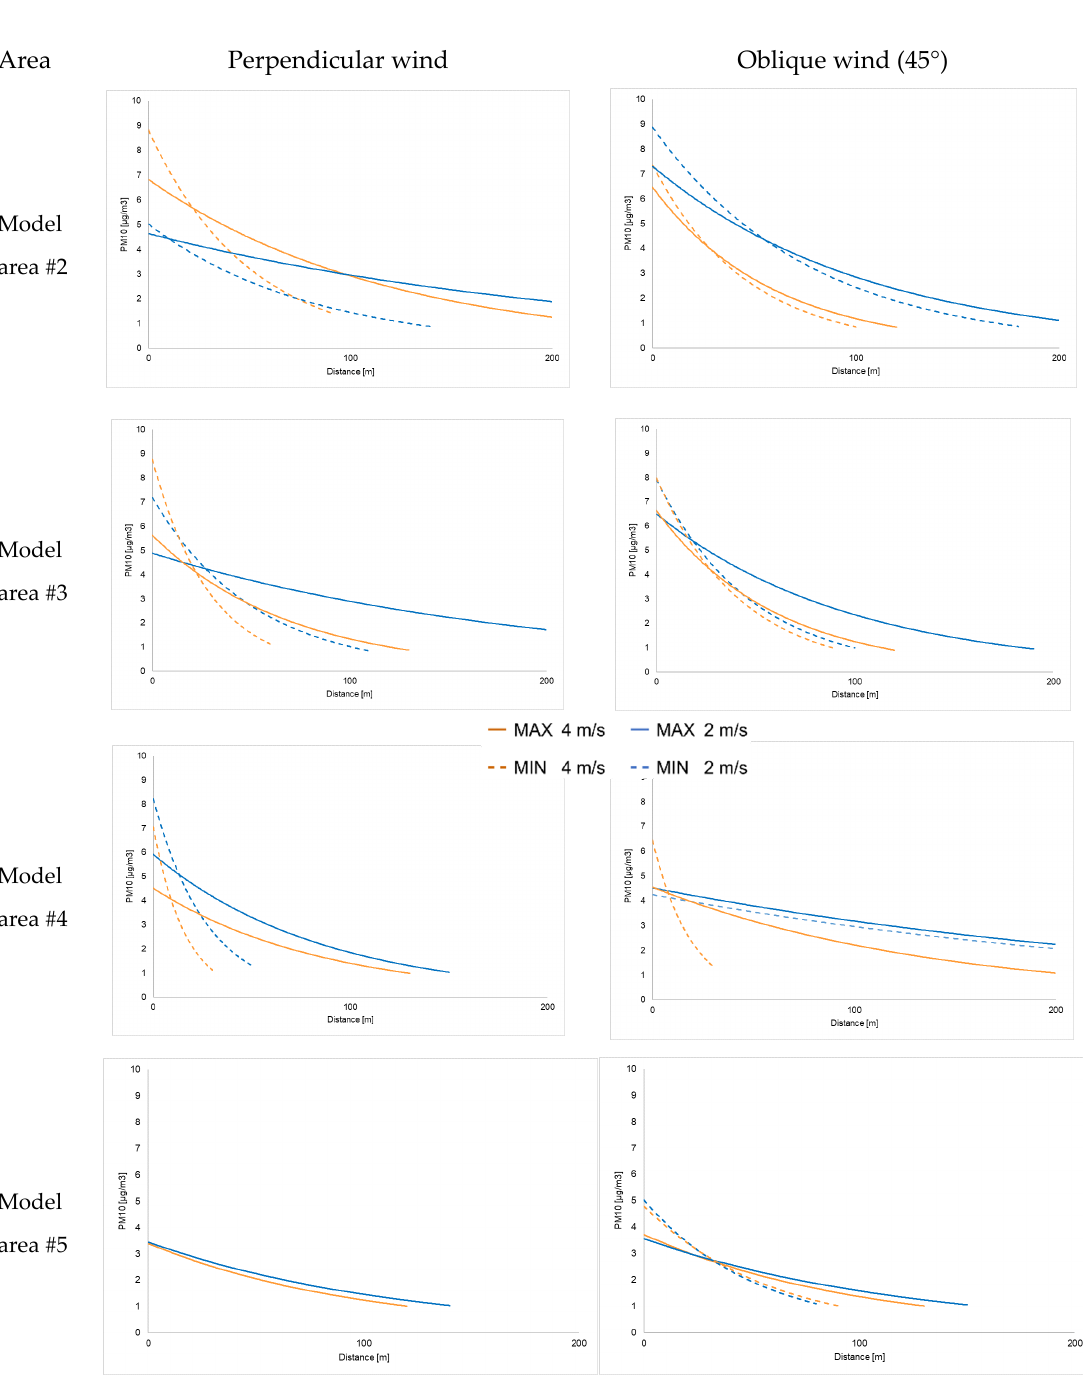
Figure 5. The relationship between the specific mass concentration of PM10 and the distance from the road, assuming the perpendicular and oblique (45°) wind directions and traffic intensity 720 car·h − 1 in each traffic direction. The calculated factors a and b are given in Table